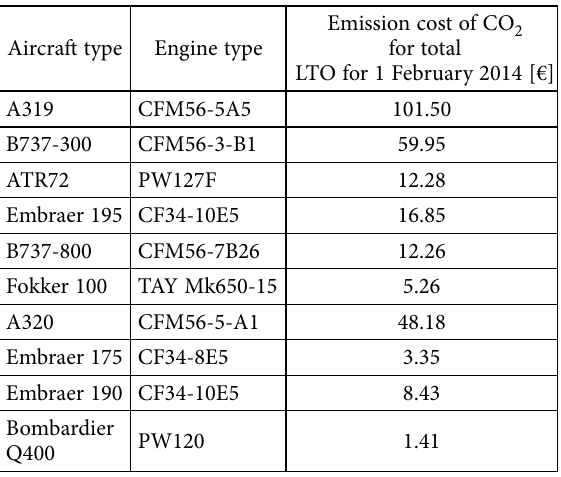
Table 5. CO 2 emission costs for different aircraft types Aircraft type